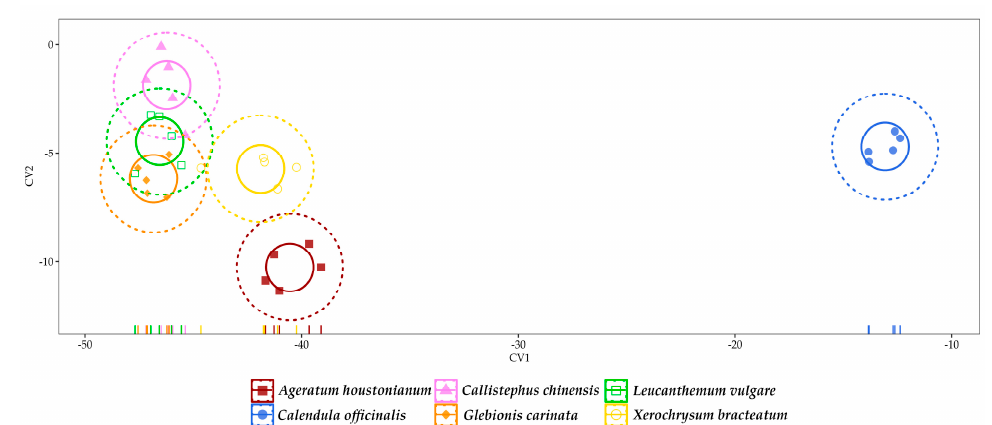
Figure 9. CVAiws biplot. Different colours and shapes distinguish individuals from different group species. The solid inner circles represent the 95% tolerance region for the population mean; the outer dotted circles represent the 95% confidence region of the group means. The coloured rugs above the x -axis represent the projection of the individuals belonging to each group.